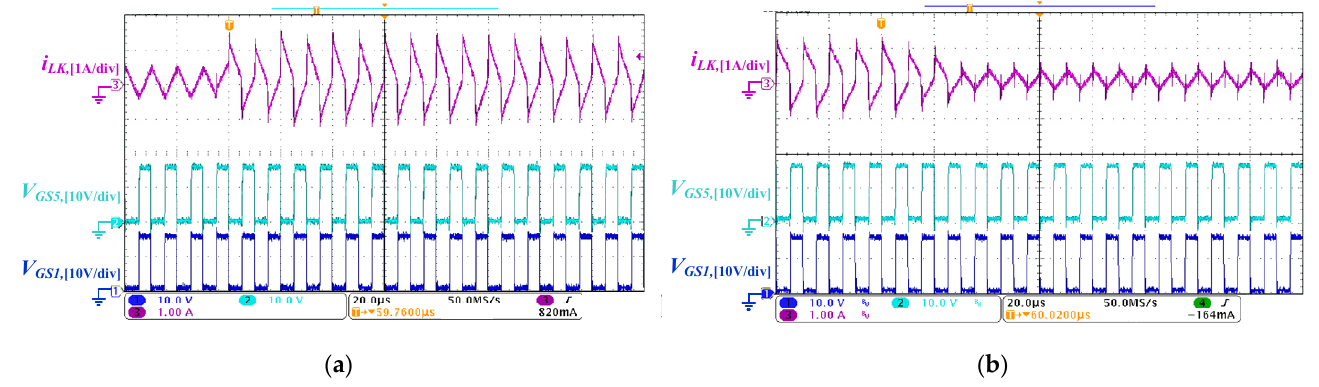
Figure 23. Waveforms of mode switching (in backward power conversion): ( a ) load change from 10 W to 200 W; ( b ) load change from 200 W to 10 W.